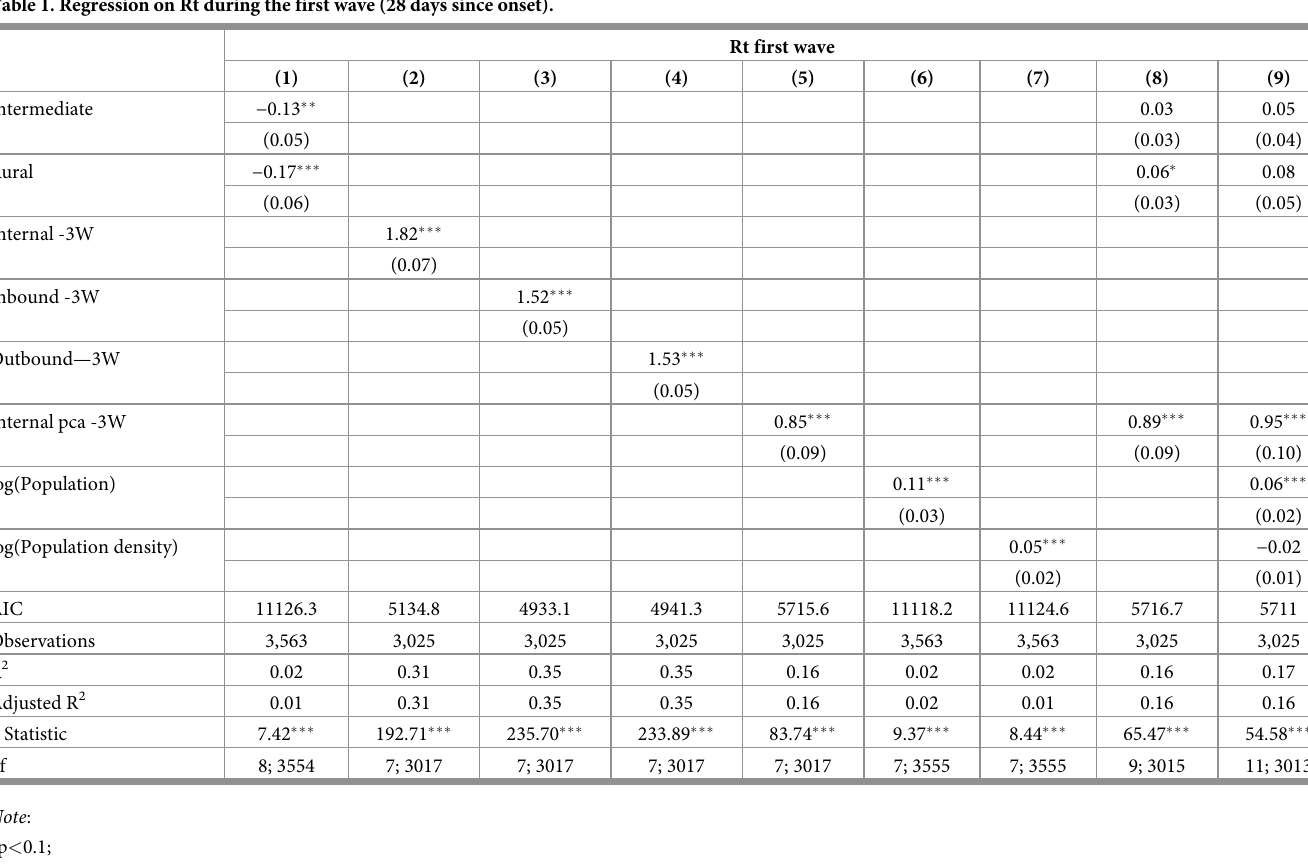
Table 1. Regression on Rt during the first wave (28 days since